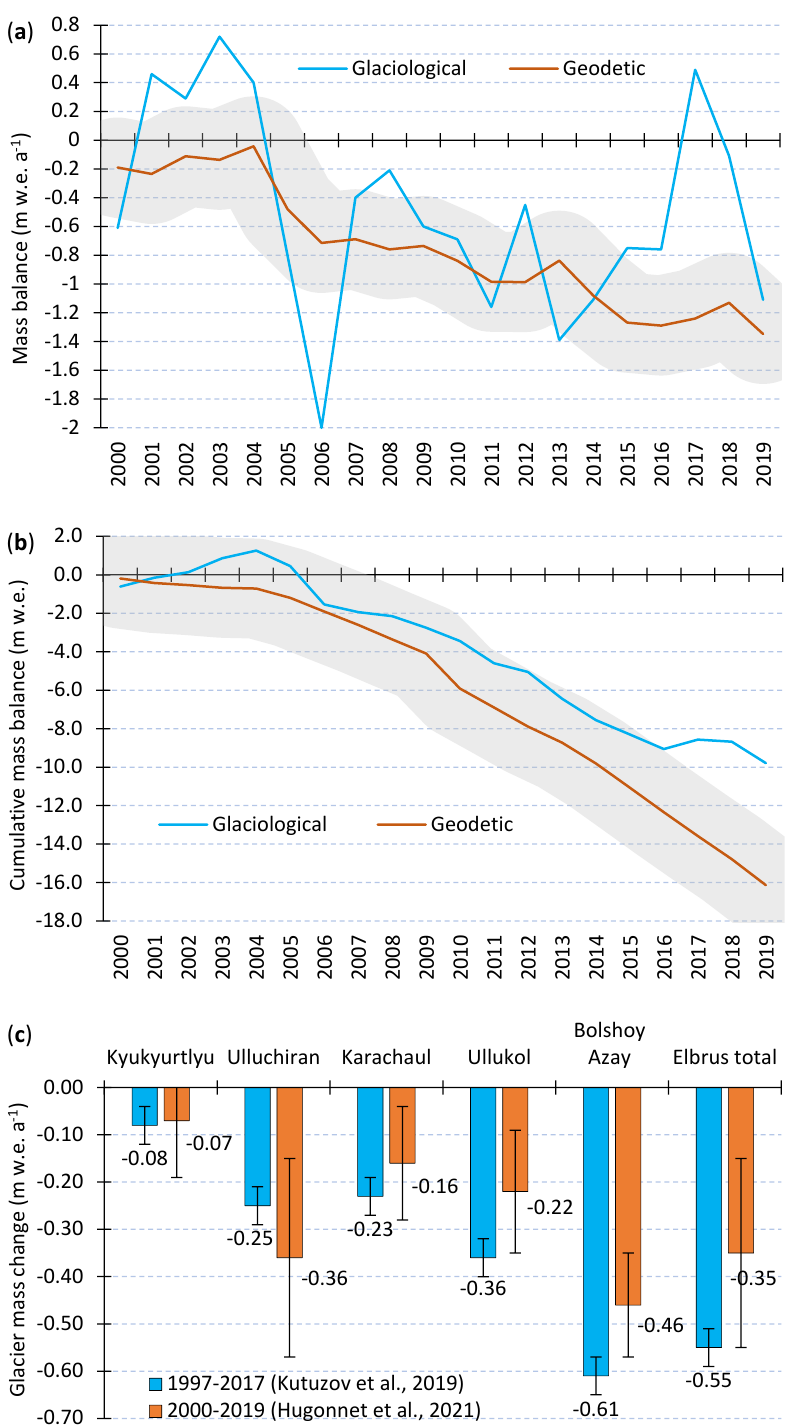
Figure 8. Comparison of mean annual mass balance (m w.e. a −1 ) ( a ) and cumulative mass balance (m w.e.) ( b ) for Djankuat Glacier using glaciological (blue) [20] and geodetic (brown) [3] methods. The light gray color corresponds to the uncertainty of the geodetic method. Comparison of mean annual mass changes (m w.e. a −1 ) for Elbrus glaciers using geodetic methods ( c ) by Kutuzov et al. (2019) [27] (blue) and Hugonnet et al. (2021) (brown) [3]. Vertical stems on panel c show an uncertainty estimation of the mean values.